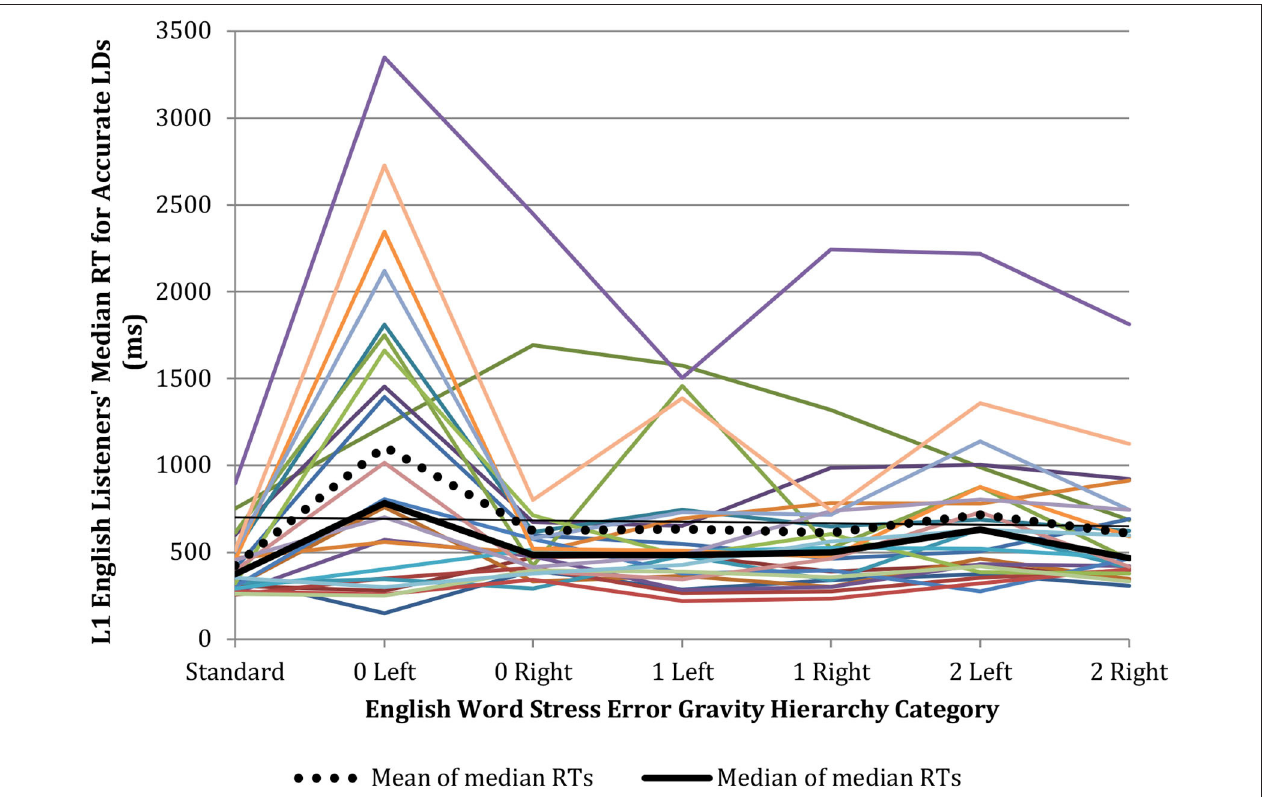
FIGURE 1 | Parallel coordinate plot of median accurate auditory LDRT for L1 English listeners with 2 + accurate LDs per Hierarchy category ( n =